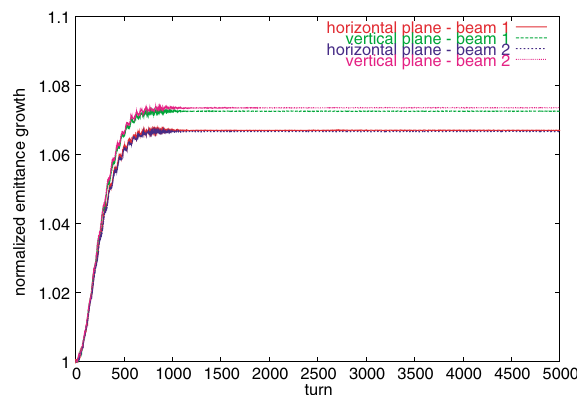
FIG. 9. (Color) The emittance evolution in the strong-strong beam-beam interaction with initial 20% mismatch in both planes of the two beams.